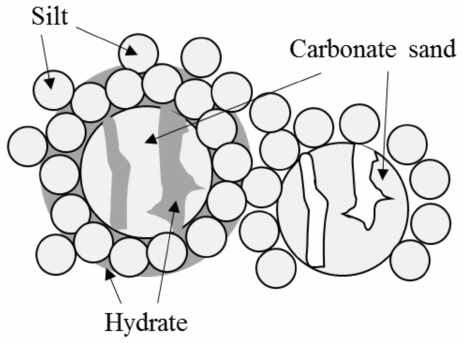
Figure 3. Proposed hydrate morphology of the CS–silt